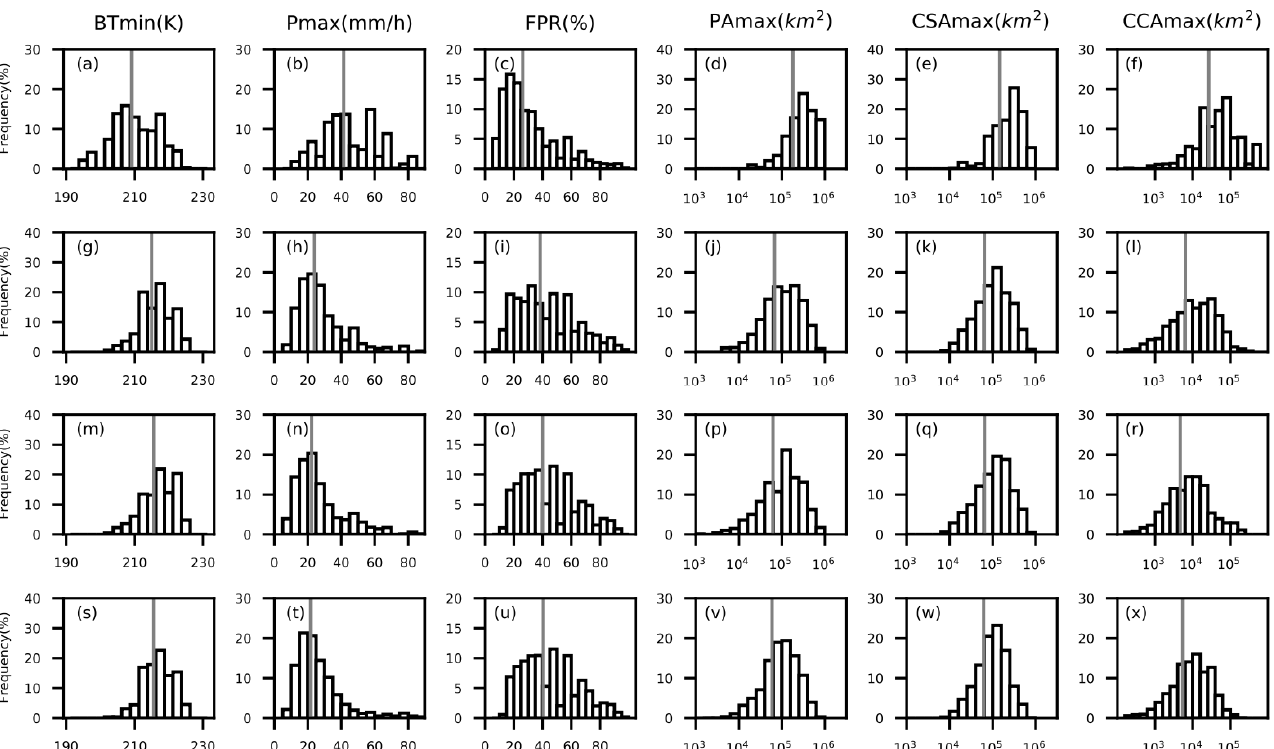
Figure 12. Distribution of physical parameters of MCSs. ( a–f ) EOs; ( g – l ) SMs; ( m–r ) WMs; ( s – x ) ENs. The gray vertical lines represent the average value, and BTmin, Pmax, FPR, PAmax, CSAmax and CCAmax represent the lowest infrared brightness temperature, max precipitation intensity, formation percentage, max precipitation area, max CS area and max CC area, respectively.